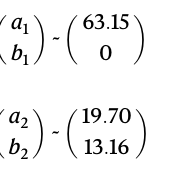
ratio (PR) values indicated by the dashed lines in ( b ) with the same colors. d Calculation of the quarter-wave plate (QWP) angle ψ -dependent photoresponse, V ph (A 1 ,A 2 , ψ )withdifferentdistributionarearatio(A 2 /A 1 )oftwonanoantennas(LH andRH). e CalculationoftheQWPangle ψ -dependentphotoresponse, V ph (A 1 ,A 2 , ψ ) withrespecttotheratioofA 2 /A 1 exhibitsa g -factortransitionfromunipolarregime to bipolar regime. The color bar shows the normalized photoresponse. f Simulated (lines)andmeasured(symbols)photoresponsesoffourtypicaldeviceswiththeir g - factor values indicated by the dashed lines in ( e ) with the same